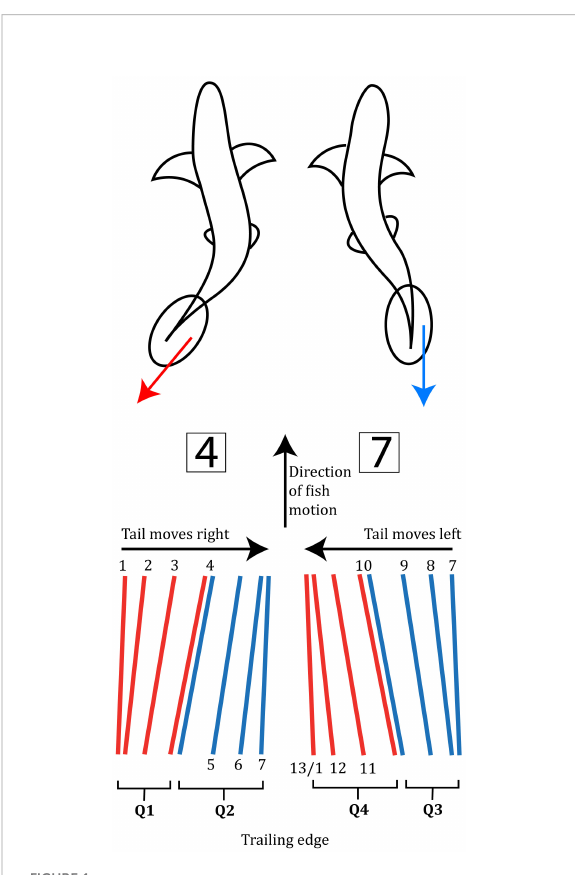
FIGURE 1 Schematic illustration of the fi n motion in respect to the fi sh during locomotion. The bottom fi gure represents the oscillatory phases, adapted from refs (Lighthill, M. J. (1969). L indicates the force normal to the direction of tail motion (equivalent to lift in airfoils), and D is the force acting in the direction of motion (i.e.: drag). Q i ( i = 1 - 4) indicates quadrants of the motion as function of angle of attack; during Q 1 : the tail ’ s angle of attack increases while the tail moves to the right, Q 2 : the tail ’ s angle of attack decreases whilst the tail keeps moving right and Q 3 and Q 4 are similar during the tail motion moving to the left (back to complete the